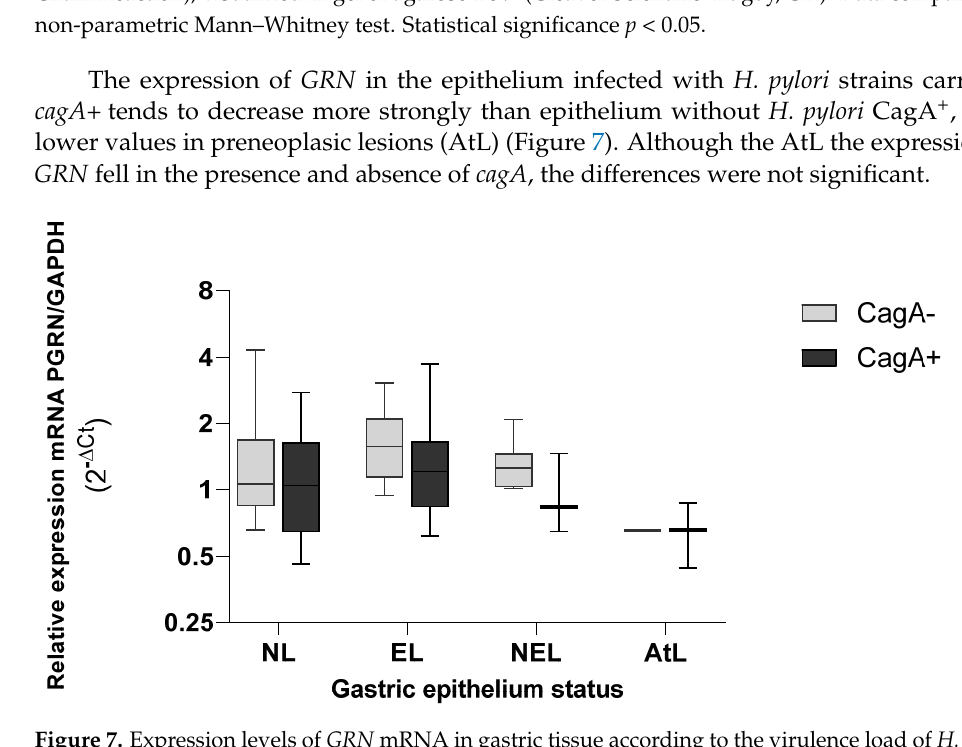
Figure 7. Expression levels of GRN mRNA in gastric tissue according to the virulence load of H. pylori CagA+ bacteria. NL = non lesions, EL = erosive lesion, NEL = non-erosive lesion, AtL = atrophic lesion. PGRN expression values calculated by the formula 2 − ∆ Ct , where ∆ Ct = Ct of GRN − Ct of GAPDH . The virulence of H. pylori was detected by amplifying the cagA gene with the PCR method. The status of the gastric tissue was determined according to the endoscopic observation report. Data compared by non-parametric Kruskal–Wallis test and comparison between two variables by Mann–Whitney. Statistical significance was established at p < 0.05.